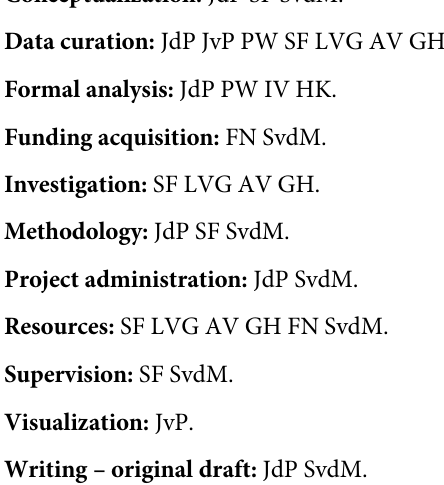
S2 Fig. Correlation of the pro-inflammatory mediators with plasma LPS levels. Plasma LPS significantly correlated with the cytokine IL6 (Fig 2A) and chemokines CCL2 and CCL3 (Fig 2B and 2C). (DOCX) S3 Fig. Graphical presentation of the correlation of the pro-inflammatory mediators TNF α and CCL3 with waist-to-hip-ratio, fasting insulin and HOMA-IR in patients (NAFLD subgroups). A significant positively correlated was found between the anthropomet- ric measurement waist-to-hip-ratio and both TNF α and CCL3 (Fig 3A and 3B). In addition, TNF α and CCL3 also correlated with fasting insulin and HOMA-IR (Fig 3C–3F). (DOCX) S4 Fig. Correlation between plasma IL6 and waist circumference and HOMA-IR in NAFLD subgroups (Fig 4A and 4B).